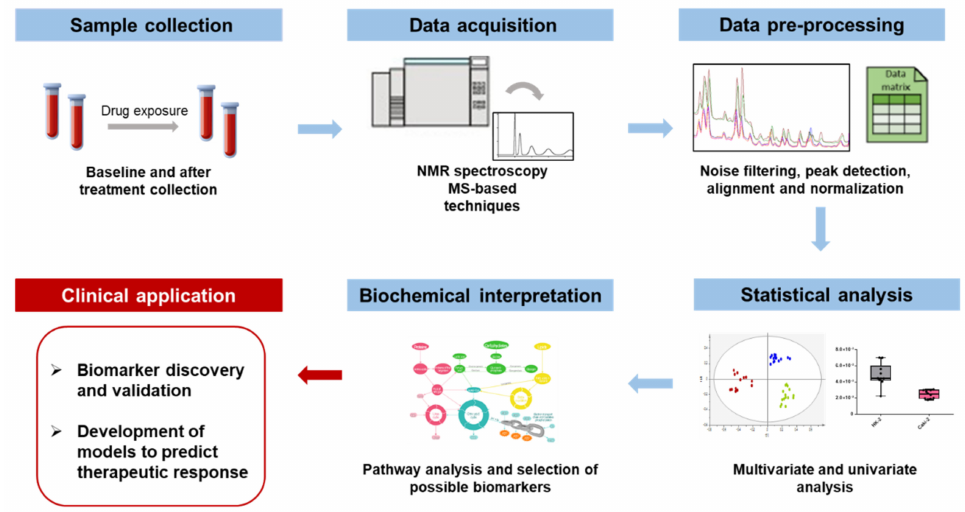
Figure 1. Overview of a representative pharmacometabolomics workflow and its main